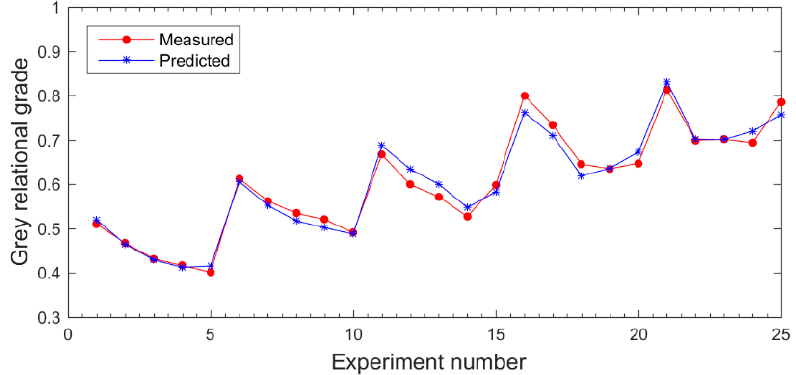
Figure 3. Comparisons of measured-predicted values for grey relation grade (GRG). Table 7. ANOVA results for the GRG model.